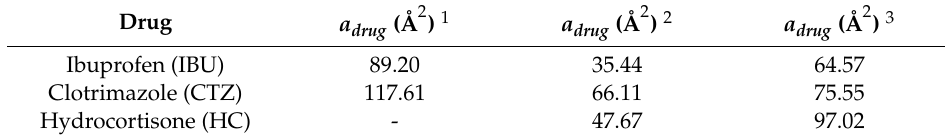
Table 3. Di ff erent values of a drug available in the literature for IBU, CTZ, and